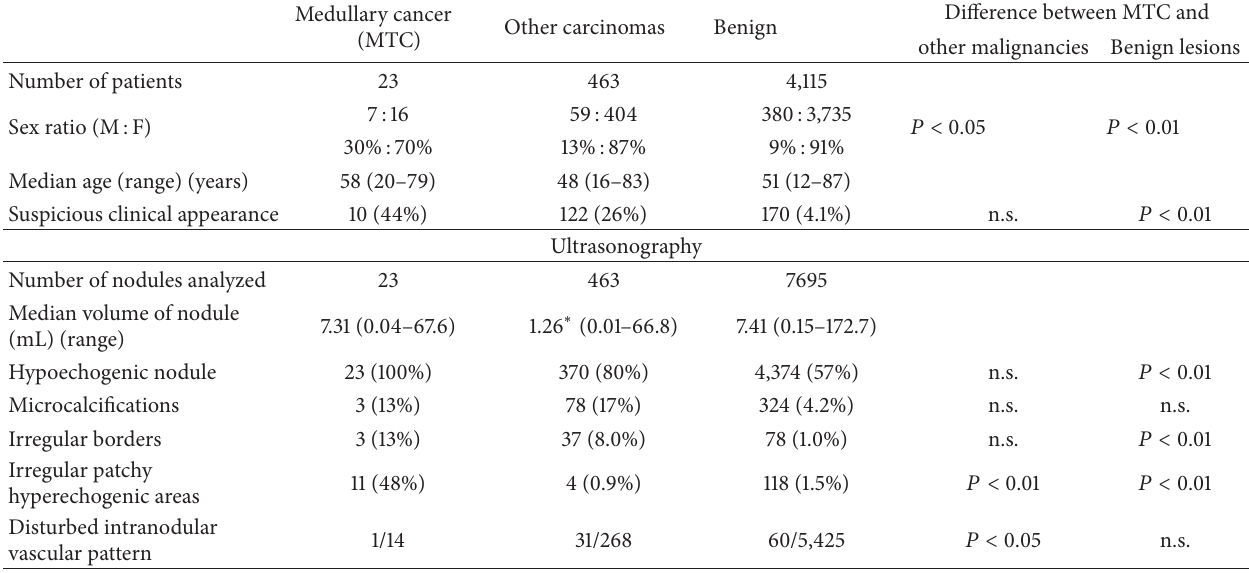
Table 1: Comparison of clinical data and ultrasonographic